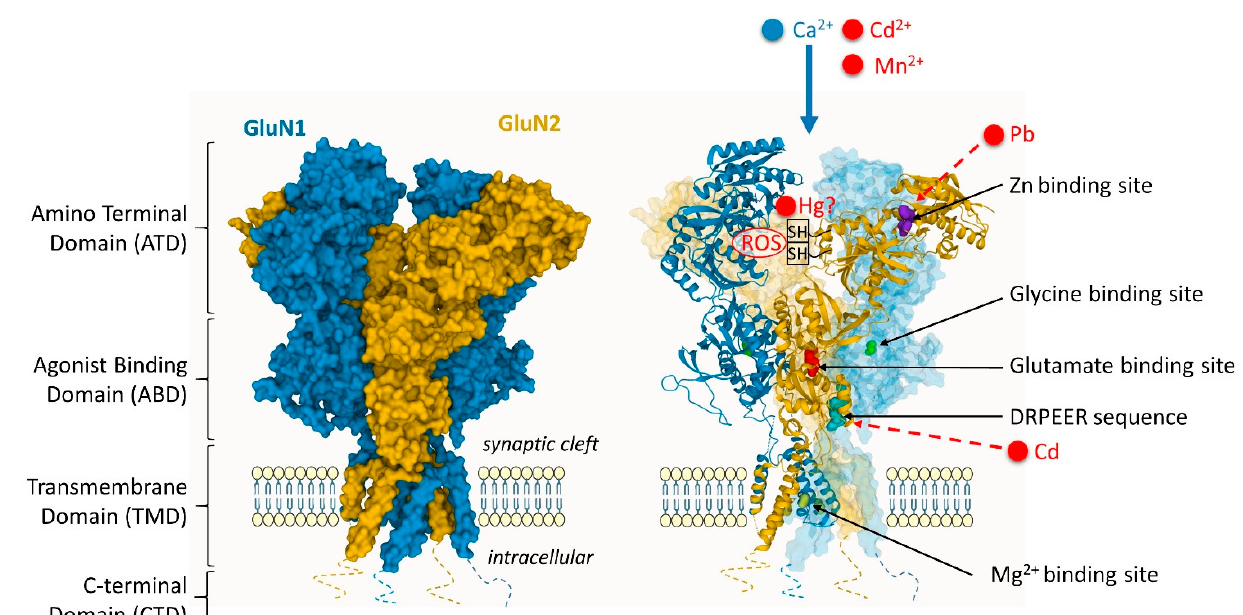
Figure 1. Interaction sites of environmental metal toxicants with the NMDA receptor. Cd 2+ neuronal uptake is mediated by the NMDAR following its stimulation. Similarly, Mn 2+ can permeate the plasma membrane through the NMDAR. Cd can bind directly to the DRPEER sequence in the extracellular domain (in the ABD/TMD linker) of the GluN1 subunit and inhibit NMDA-mediated current. Pb competes with zinc to the zinc-binding site of the GluN2 subunit and alters the receptor function. In the case of Hg, there are some indications for interactions with the cysteine -SH groups involved in the control of NMDAR activity, although this suggestion still needs experimental evidence. In most cases, metals could induce ROS that would interact with the –SH groups of the NMDAR. Structure of the GluN1/2B NMDAR (Protein Data Bank accession 4PE5 [32]). Figure inspired from Hansen et al. [52].